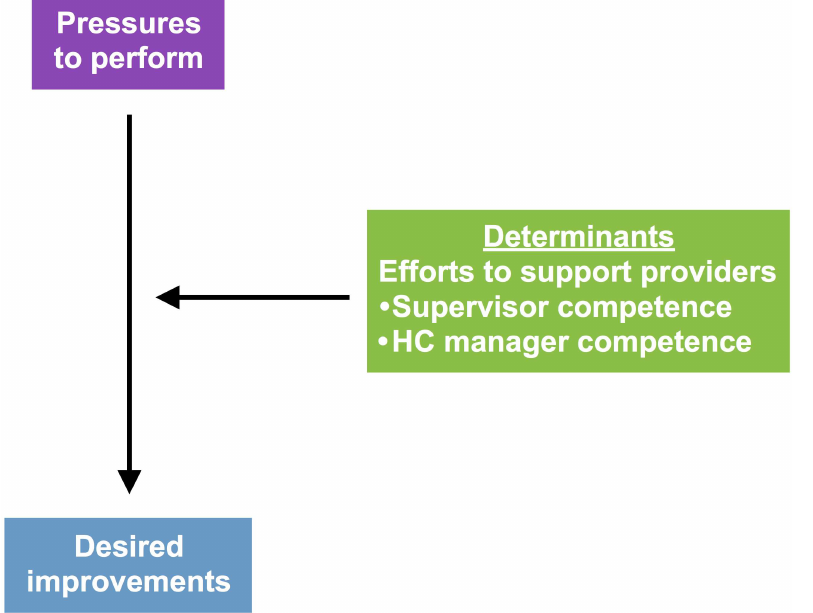
Fig 2. Support as key determinant of the effect of performance